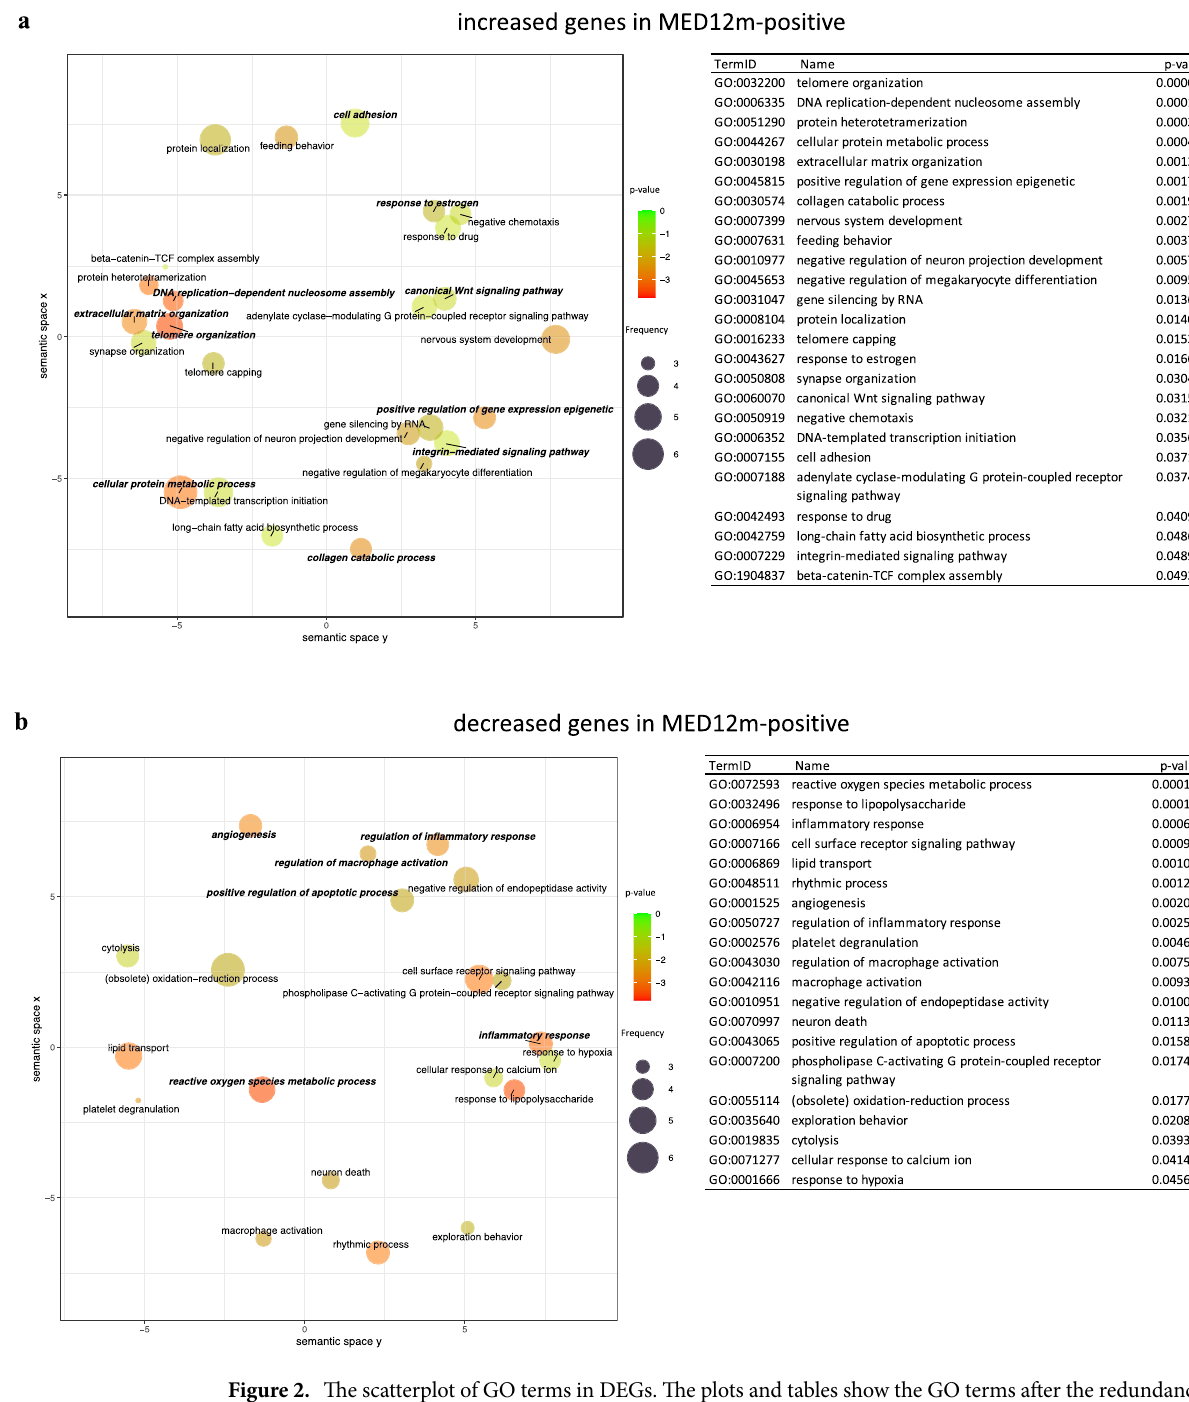
Figure 2. The scatterplot of GO terms in DEGs. The plots and tables show the GO terms after the redundancy reduction in the MED12m-positive-increased ( a ), -decreased ( b ), the MED12m-negative-increased ( c ), and -decreased ( d ) DEGs. The colors indicate the log10(p-value) of the summarized GO terms. The size of the circle indicates the frequency of the GO term in the underlying GO database. The circles of more general terms are plotted larger. The color and the size of circles are plotted according to the default setting of REVIGO 39 . ( e ) Summary of GO analysis in the MED12m-positive and -negative uterine fibroids (drawn with Microsoft PowerPoint). The specific terms to the MED12m-positive uterine fibroids, the MED12m-negative uterine fibroids, and commonly detected terms are shown. Red and blue mean higher and lower expression compared to the